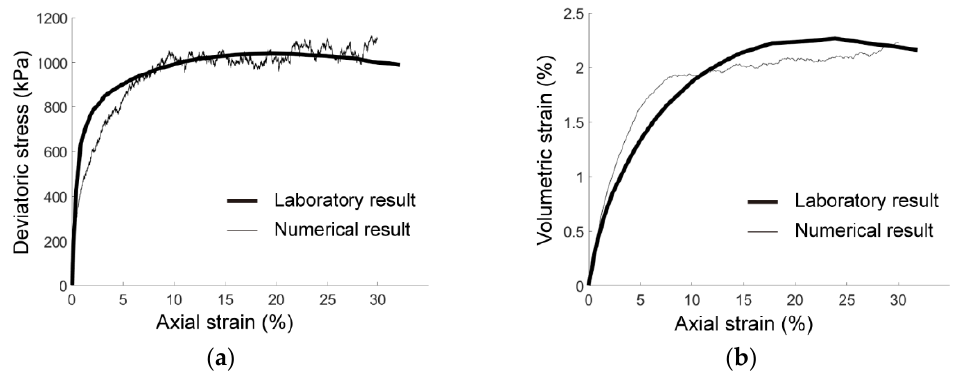
Figure 5. Numerical calibration results: ( a ) deviatoric stress as a function of axial strain; ( b ) volumetric strain as a function of axial strain. Table 1. Descriptors for particle clumps in the numerical calibration model. Table 2. Micro parameters for the rolling resistance linear model.